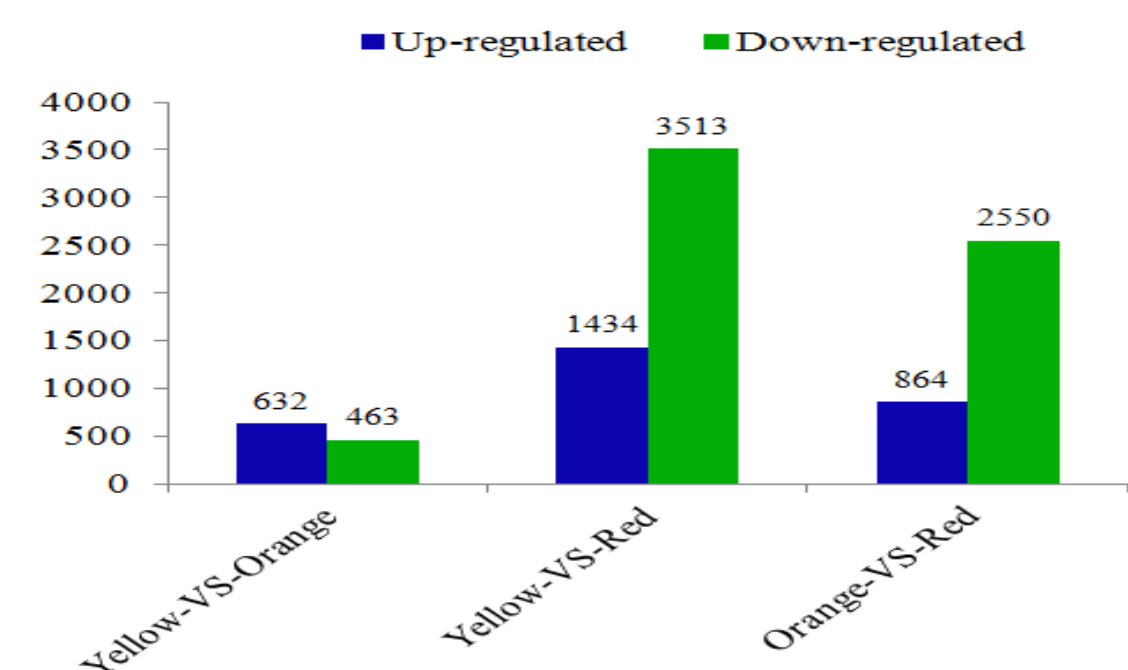
Figure 4. KOG functional classification of ‘Huaxiu’ plums ( P. salicina ) unigenes.